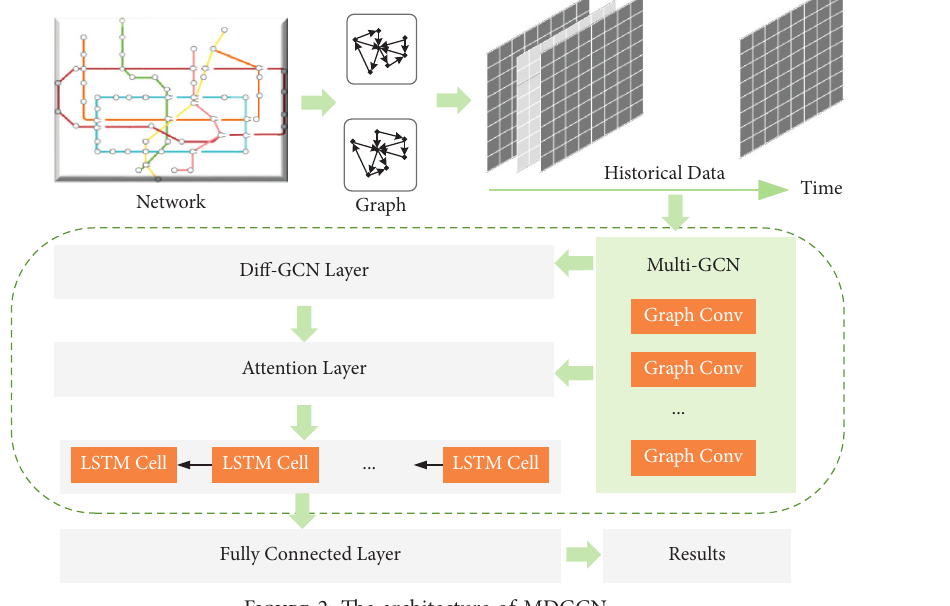
Figure 2: The architecture of